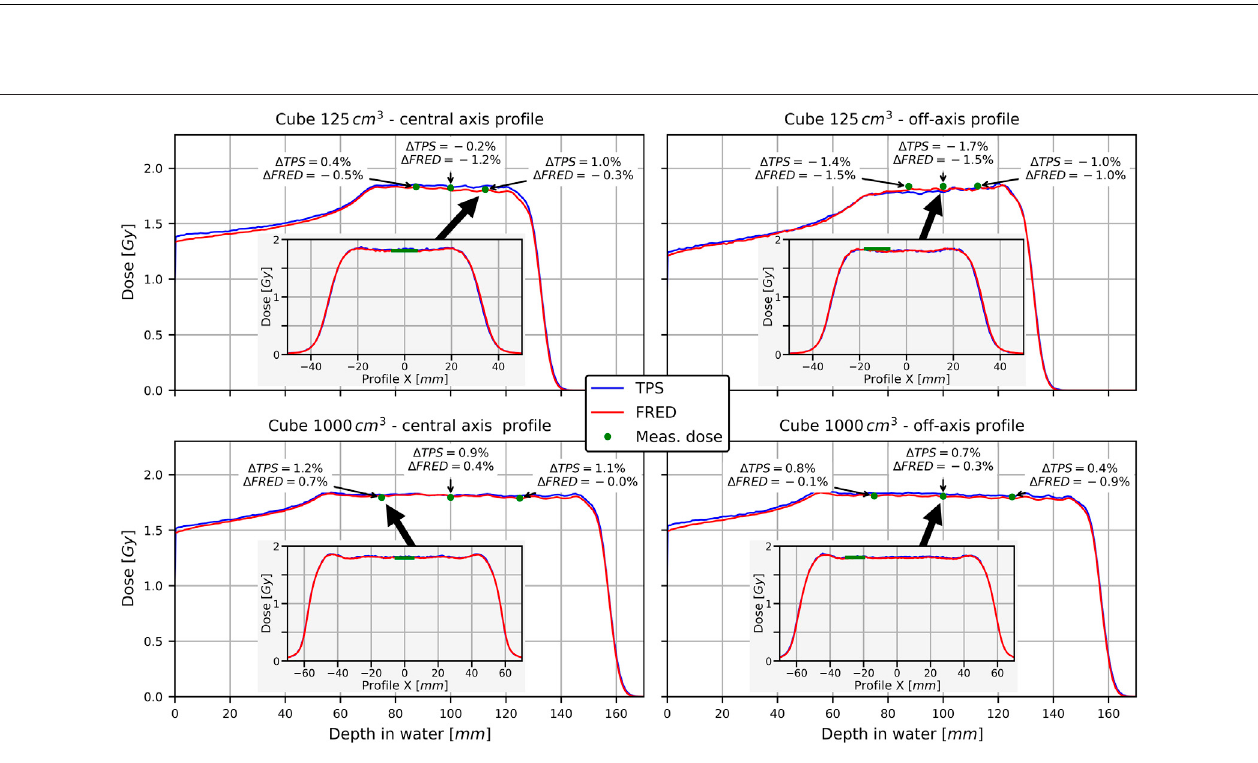
Frontiers in Physics |